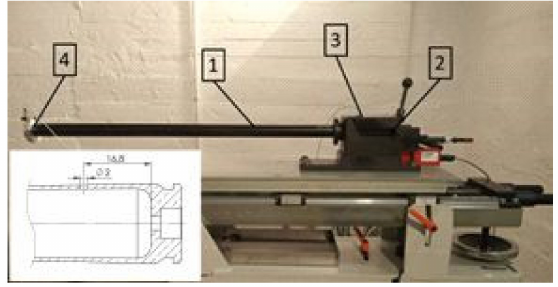
Figure 4. The setup for measuring the pressure inside the cartridge case: 1—12.7 mm ballistic barrel, 2—holder, 3—pressure gauge, 4—pressure gauge signalling the projectile leaving the muzzle.